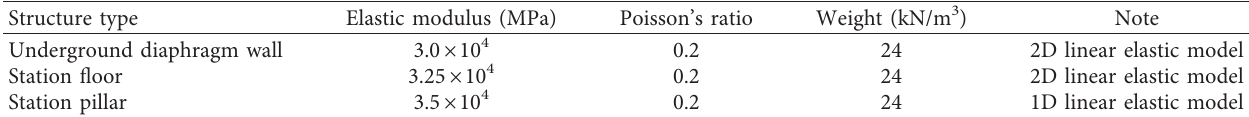
Table 3: Constitutive parameter of the main structure in the existing station.